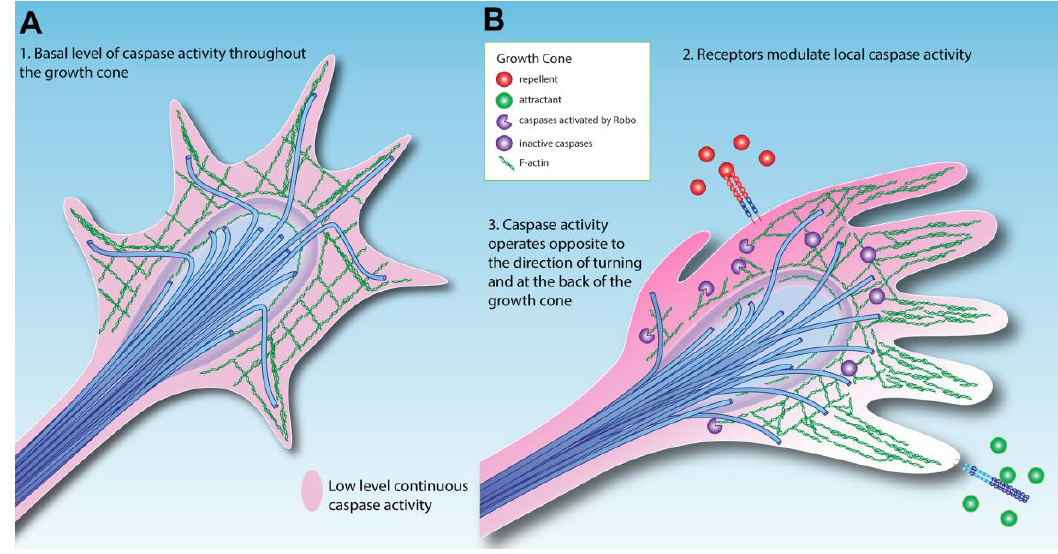
Figure 2. Model for caspase activity in the growth cone. ( A ) Simple low-level activation of caspases throughout the growth cone. ( B ) Attractant and repellent cues modulate caspase activity via cell surface receptors, altering the growth cone trajectory. In this model, repellents increase caspase activity, while attractants decrease caspase